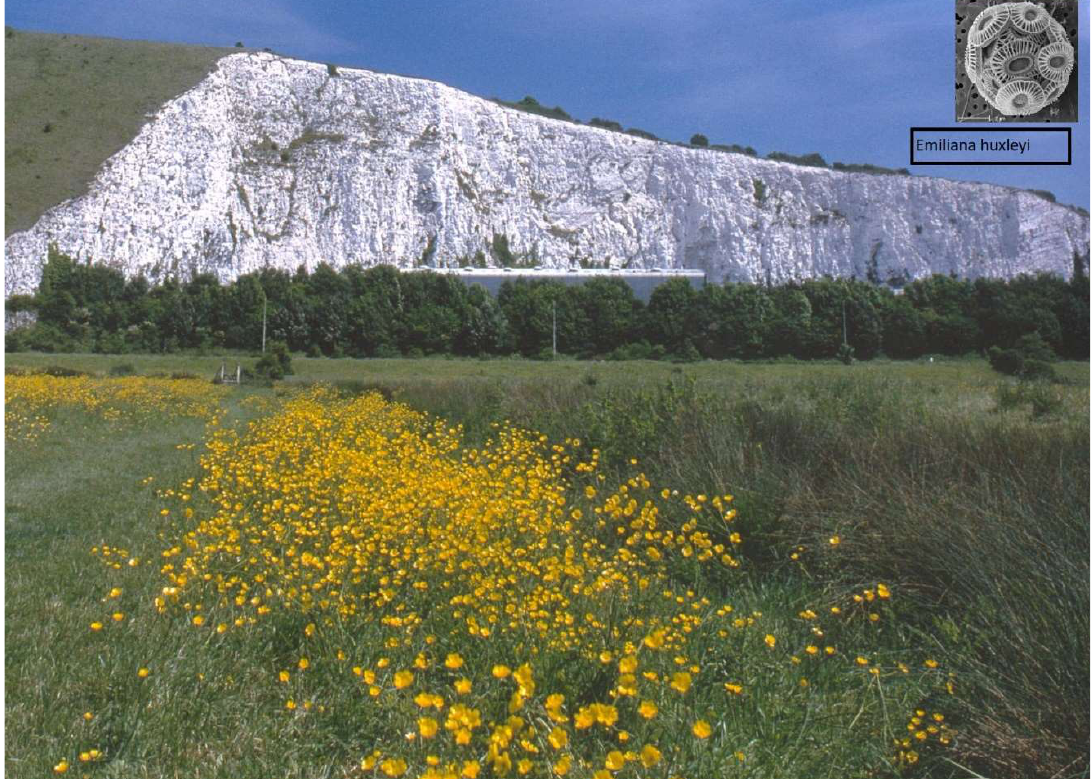
Figure 8. Chilly Brook chalk cliffs with E. huxleyi . Coccolithophores such as E. huxleyi (inset) constructed massive soft chalk deposits of calcium carbonate during the cretaceous period (145–65 MYA), now seen here from across the Chilly Brook water meadows dominated by Ranunculus acris , adjacent to the River Ouse in the South Downs National Park at Lewes, UK. This view encapsulates the entire evolutionary progression from the simplest unicellular protists such as E. huxleyi to advanced dicots such as R. acris at the pinnacle of alternation of generations, all dependent on calcium. (Photo: DTAL).